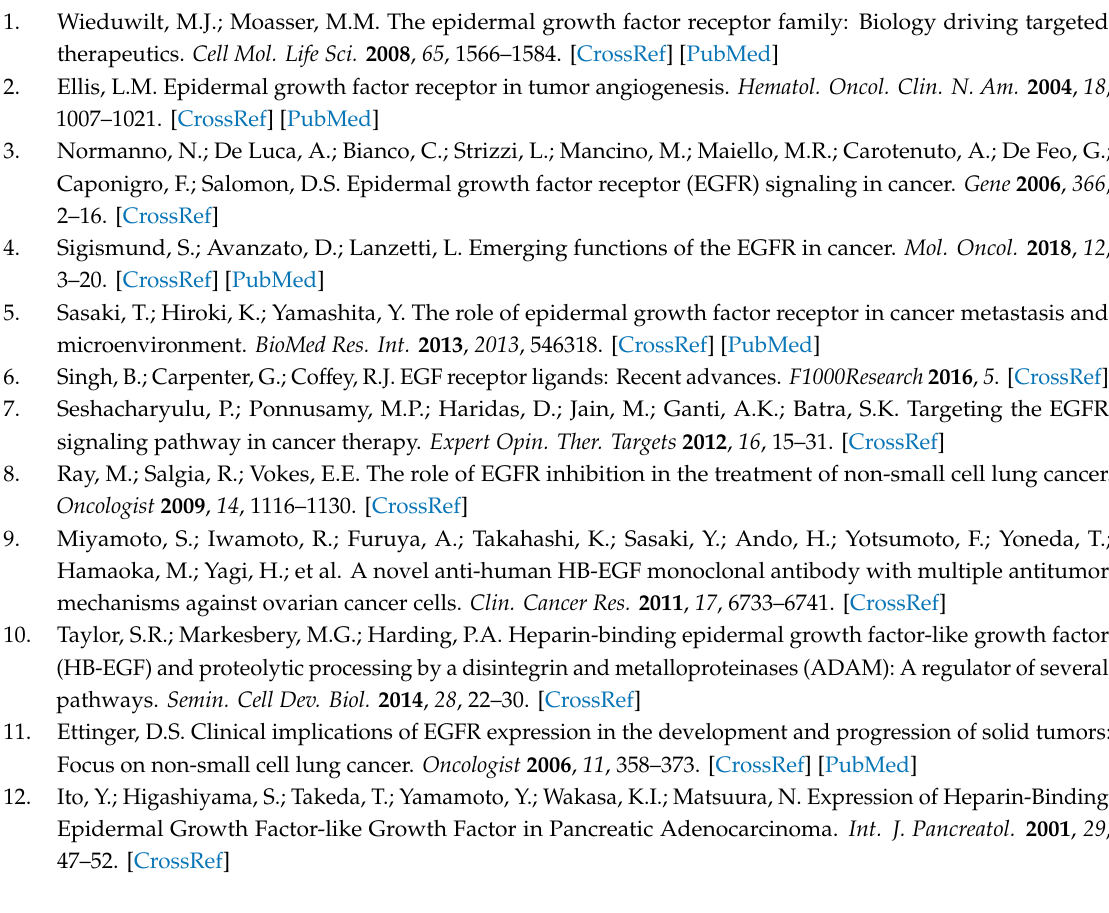
Figure S1: Relative mRNA levels of MMP7 in MMEC after indirect and direct coculture with RPMI 8226 cells, Figure S2: Supernatant of RPMI 8226 cocultures stimulates in vitro MMEC migration and angiogenesis, Figure S3: HB-EGF modulates the secretion of angiogenesis-related proteins by MMEC, Figure S4: MM plasma cells do not a ff ect HER4 expression on bone marrow endothelial cells, Table S1: Taqman qRT-PCR probes used for